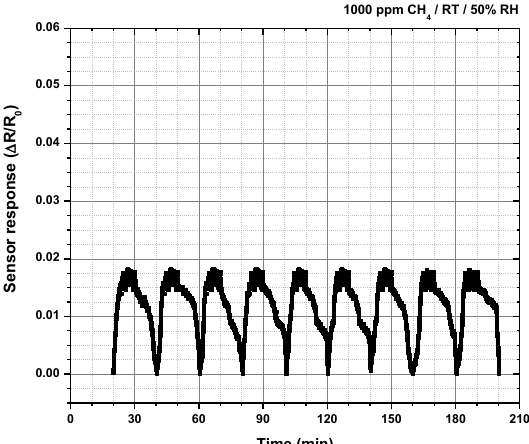
Figure 11. Response of the sensor to 1000 ppm methane in humid air at RT. Measuring cycle: 10 min humid air flow, followed by 10 min humid air + 1000 ppm methane flow. Cycle begins at t = 20 min.